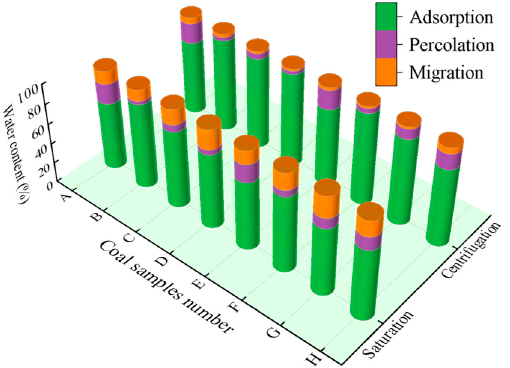
12 of 17 Figure 9. Pore size distribution of coal samples: ( a ) sample A; ( b ) sample B; ( c ) sample C; ( d ) sample D; ( e ) sample E; ( f ) sample F; ( g ) sample G; ( h ) sample H. From the pore network composition ratio in Figure 9, adsorption pores account for the largest proportion of total pores in the coal samples. Adsorption pores are specially developed in samples B, C, D, and F. Percolation pores are a small part of the pore system. The development of migration pores in sample G is higher than that in other coal samples. The connectivity between adsorption pores and percolation pores is lower than that be- tween percolation pores and migration pores. The distribution of adsorption pores in coal samples is similar, and the pore volume proportion is high based on Figures 8 and 9. The coal samples are mainly composed of a relatively uniform distribution of micrometer and nanometer pores. The distribution of percolation pores and migration pores is relatively complex. 5. Discussion 5.1. Water Content of Pores Analysis Figure 10 shows the pore water content of samples before and after centrifugation at 1.46 Mpa. The results in Table 2 show that the adsorption pores volume accounts for 67.60~85.82% of the total pore volume, the percolation pores volume accounts for 3.20~19.86%, and the migration pores volume accounts for 10.98~19.59%. The proportion of pore water content shows that the adsorption pores account for most of the total volume of coal samples in Pingdingshan, followed by percolation pores and migration pores. Af- ter centrifugation, the water content distribution of the eight samples changed obviously. Residual water mainly exists in the adsorption pores. The water content in the adsorption pores of the samples increased by 6.94% at least and by 19.07% at most. The water content of percolation pores does not change. The decrease in water content in migration pores is